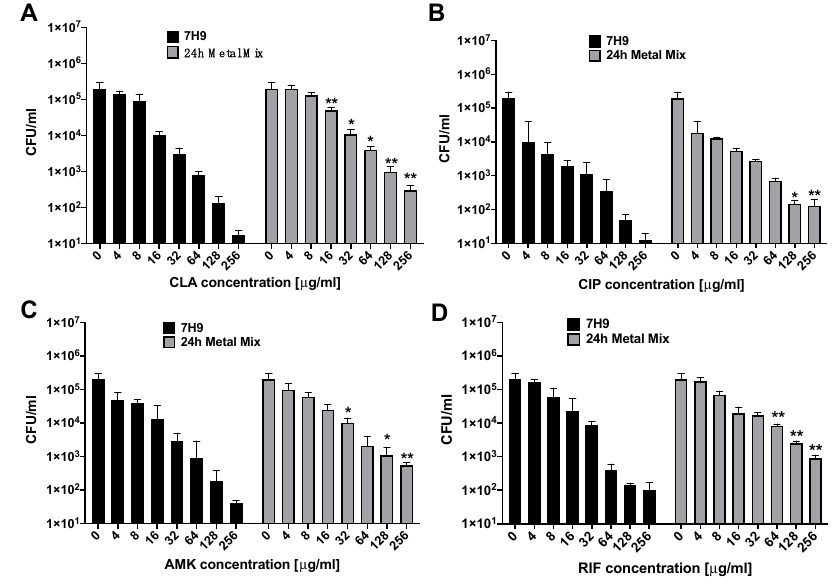
Figure 3. Antibiotic efficacy against MAH 104 in the 7H9 culture and the 24 h metal mix. The effect of the 24 h phagosome metal concentrations was evaluated by culturing MAH104 either in the 7H9 growth or the 24 h metal mix for 24 h. After, bacteria of two phenotypes were exposed to ( A ) CLA, ( B ) CIP, ( C ) AMK and ( D ) RIF in the concentration range of 4–256 μ g/mL for additional 24 h at 37 °C. Next, bacteria were centrifuged, serially diluted and plated on 7H10 agar plates for CFU determination. Data represent the means ± standard deviations (SD) of three independent experiments performed in duplicates. * p < 0.05 or ** p < 0.01 statistical significance between the same drug concentration groups for bacteria exposed to the 7H9 broth and the 24 h metal mix.